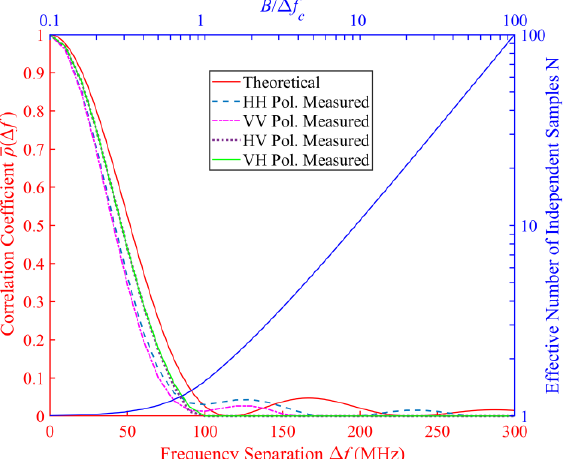
Figure 12. Angular variations of the ( a ) mean and ( b ) standard deviation of the co-pol phase differ- ence.